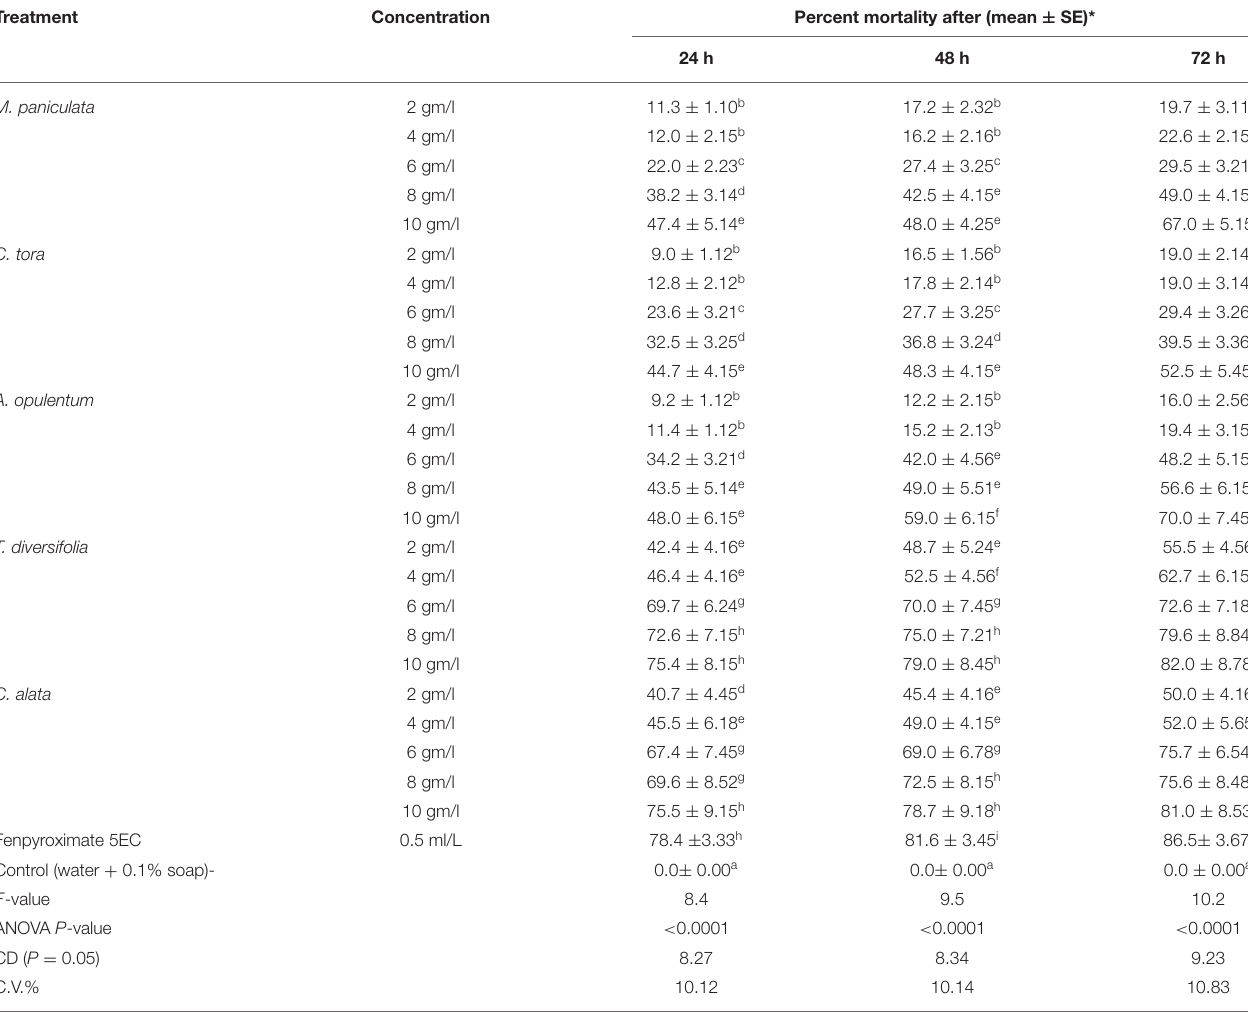
TABLE 1 | Acaricidal activity of the pesticidal plant extracts (leaf disc experiment). Treatment